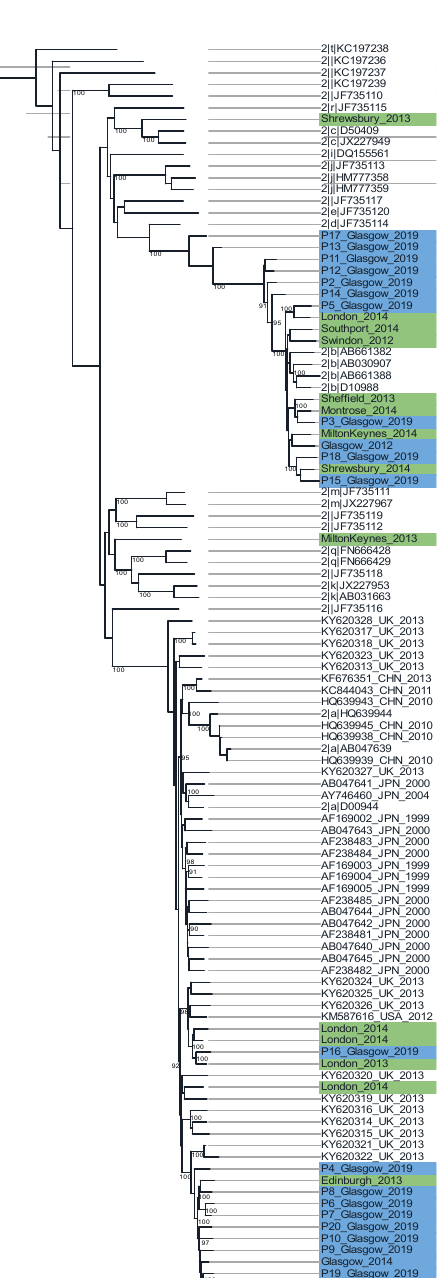
Figure A1. Maximum likelihood tree of whole nucleotide HCV genomes constructed with 1000 bootstrap replicates, showing the whole HCV genotype 2 clade using sequences from GenBank and cases. Tip labels with a background colour distinguish between individuals from Glasgow and those outside of Glasgow. Non highlighted tip labels are reference sequences, down- loaded from the Flaviviridae study group, International Committee on Taxonomy of Viruses (https://talk.ictvonline.org/ictv_wikis/flaviviridae/w/sg_flavi/54/hepaciviruses, accessed on 27 April 2022), which has a curated alignment of all reference HCV geno-subtype genomes, and full- length genotype 2 sequences downloaded from GenBank